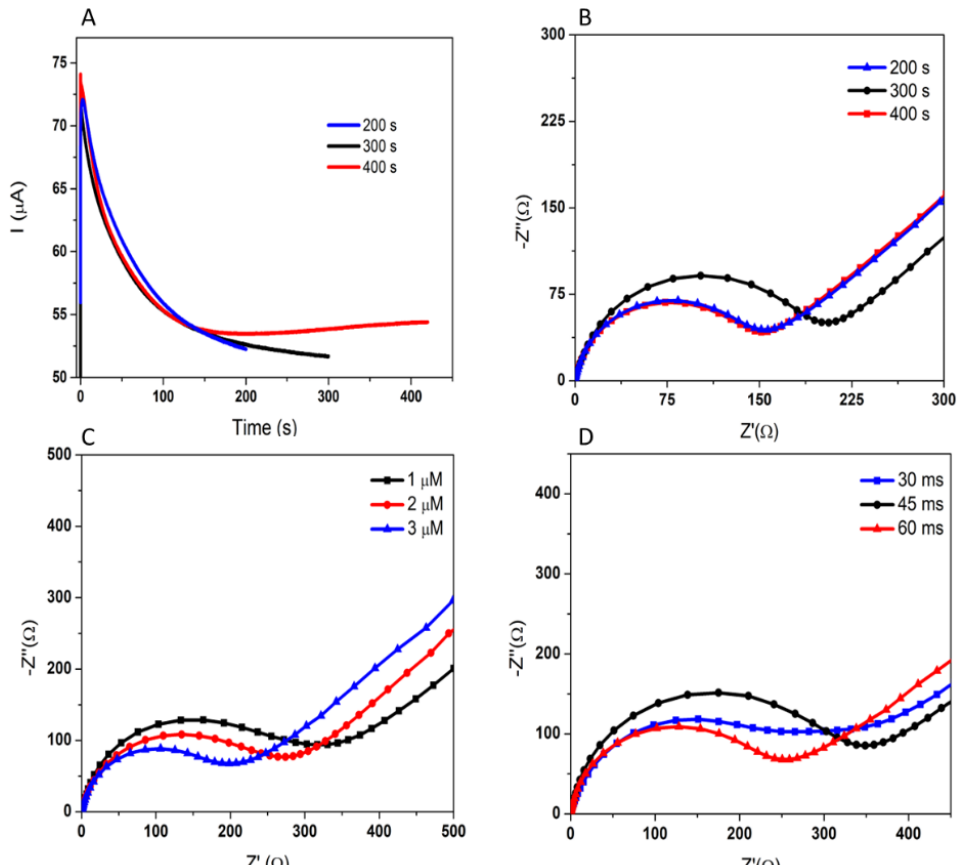
Figure 3. Optimization of the APT immobilization; the optimal parameters are represented in black: variation in the current during the APT immobilization by MPA ( A ); the Nyquist plots characterizing the APT immobilization after different durations ( B ); after different APT solution concentrations ( C ), and after different pulse durations ( D ).